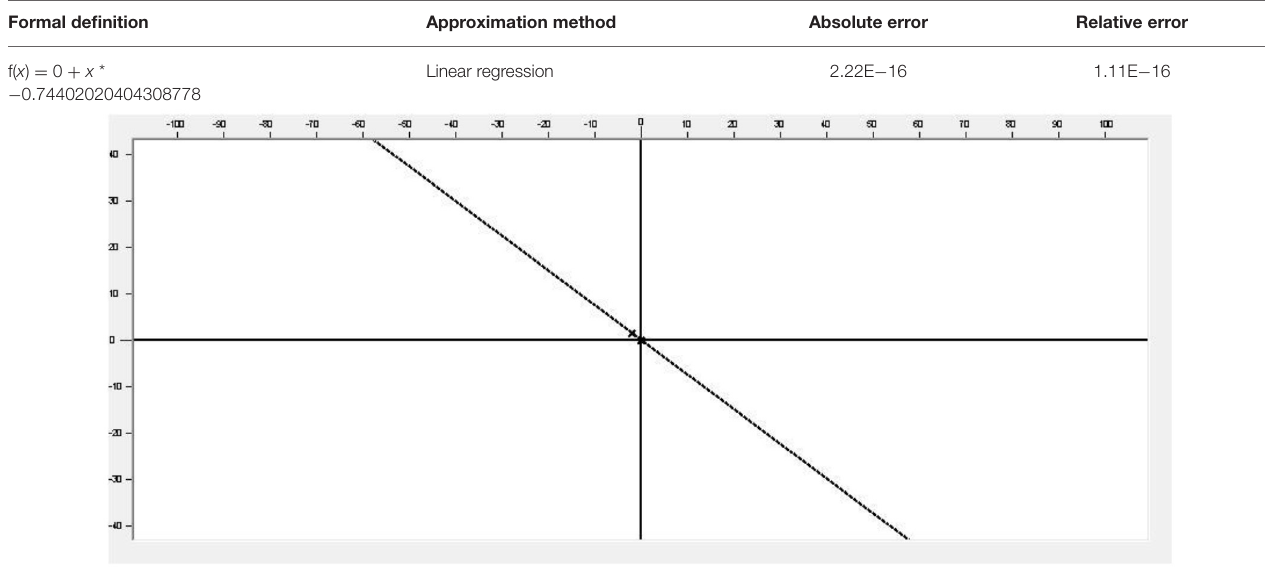
TABLE 7 | Function estimation quadrant II: UxE focal conduct.